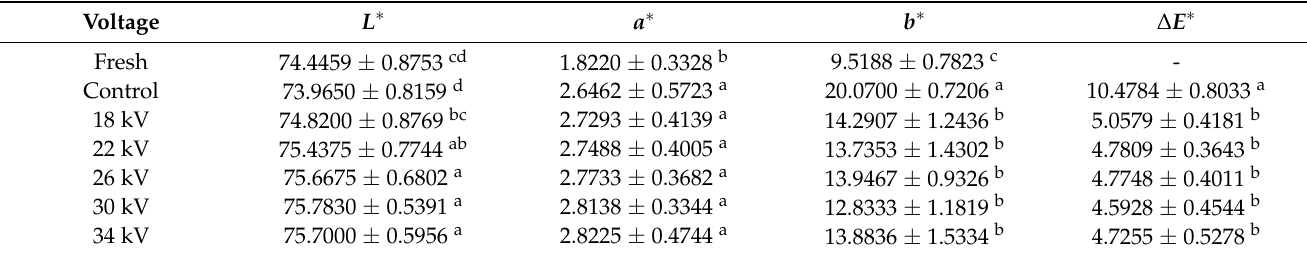
Table 1. Color changes in Shiitake mushroom slices before and after drying.